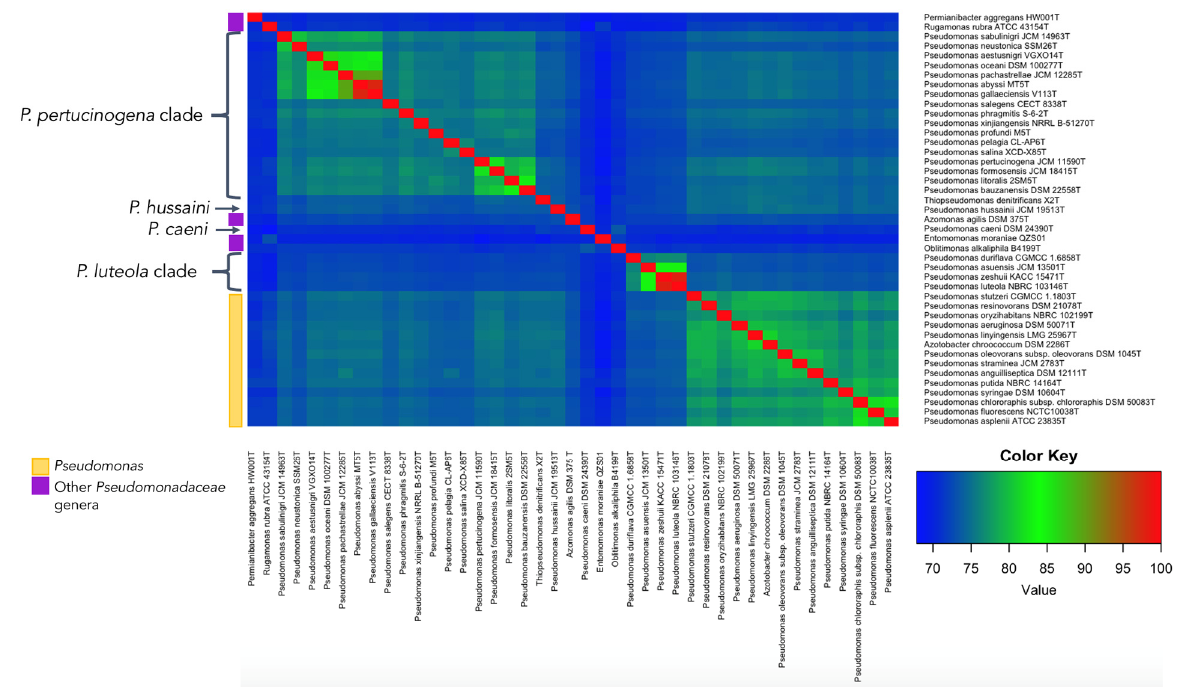
Figure 7. Heatmap of ANIb values calculated for the genomes of the type strains suggested as novel genera and the genomes of other representative Pseudomonadaeae type strains.